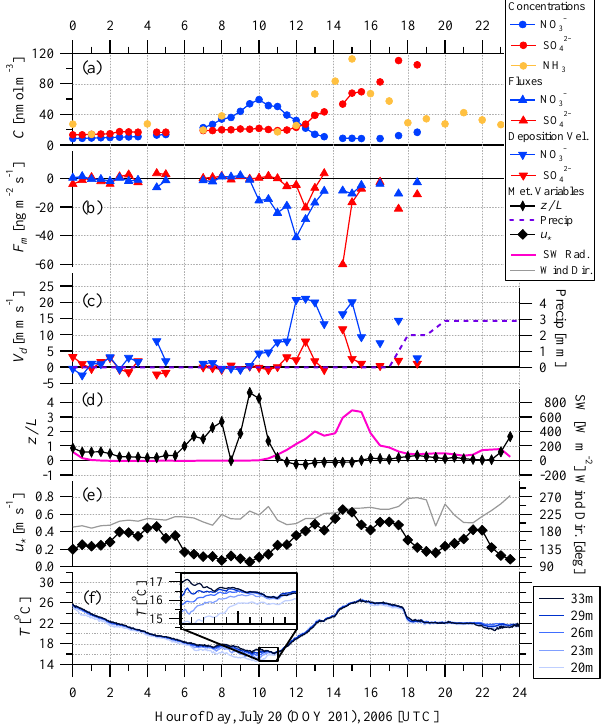
Figure 5. NO 3- and SO 42- concentrations (a), mass fluxes (b), and deposition velocities (c), 2 Fig. 5. NO − and SO 2 − concentrations (a) , mass fluxes (b) , and compared to NH 3 concentration (a) and other meteorological variables (d,e) on 20 July 2006. 3 3 4 deposition velocities (c) , compared to NH 3 concentration (a) and Temperatures at various heights are shown (f). Inset in (f) shows temperatures from 10:00 to 4 other meteorological variables (d, e) on 20 July 2006. Temperatures 11:00 UTC. 5 at various heights are shown (f) . Inset in (f) shows temperatures from 10:00 to 11:00UTC.